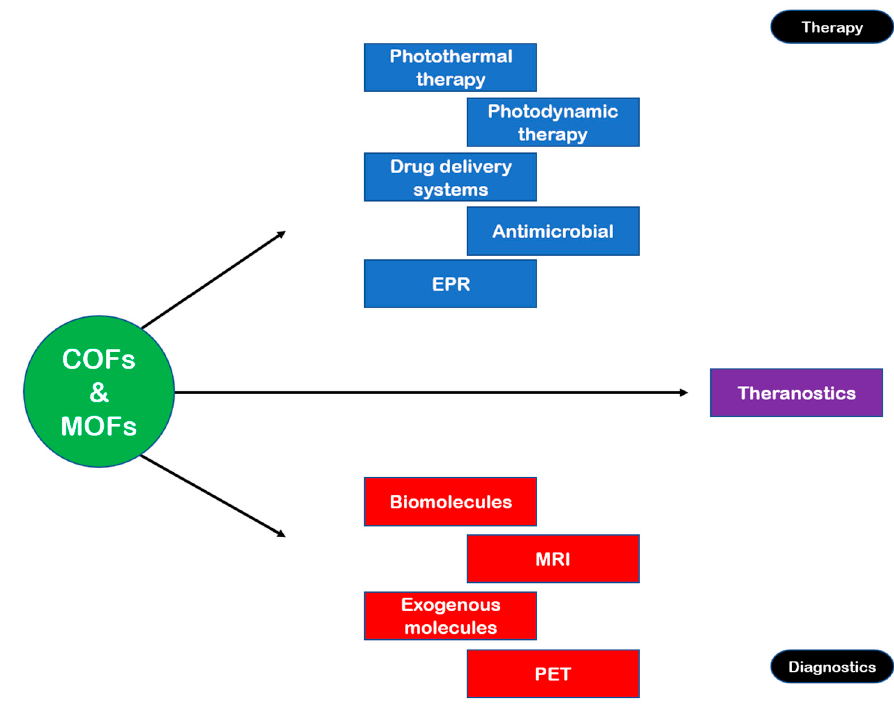
Figure 2. Concept map of COFs and MOFs as therapeutic and diagnostic agents.